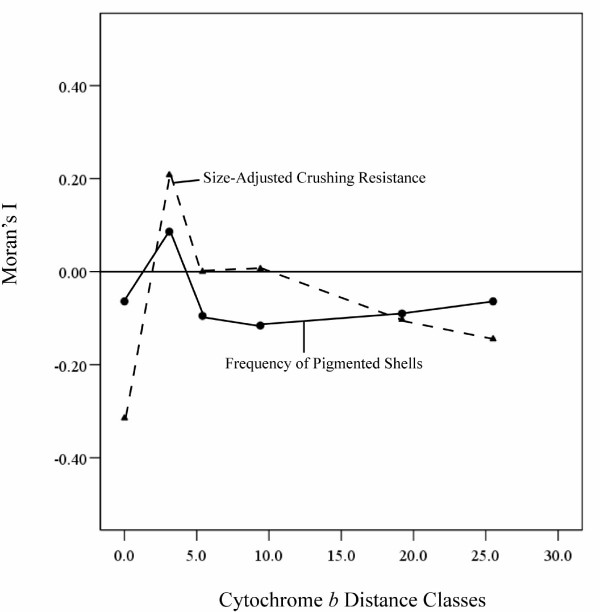
A and B Relationship between Moran's I and cytochrome b pairwise distance classes (correlograms) for two Mexipyrgus traits: size-adjusted crushing resistance (triangles and dashed line) and frequency of pigmented shells (closed circles and solid line).